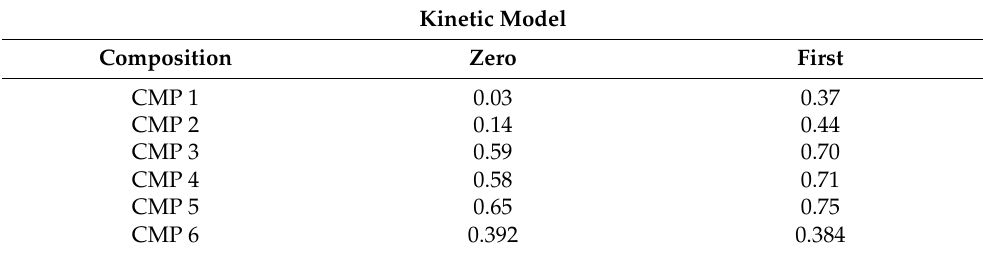
Figure 4. Release profiles of the different o/w ointment compositions. The best result was achieved by CMP 4, closely followed by CMP 2 and 5, while CMP 3 and 6 showed a greater sustained-diffusion profile in the experiment. Results represent the mean values of six samples ± SD. Table 7. Correlation-coefficient values of the compositions.